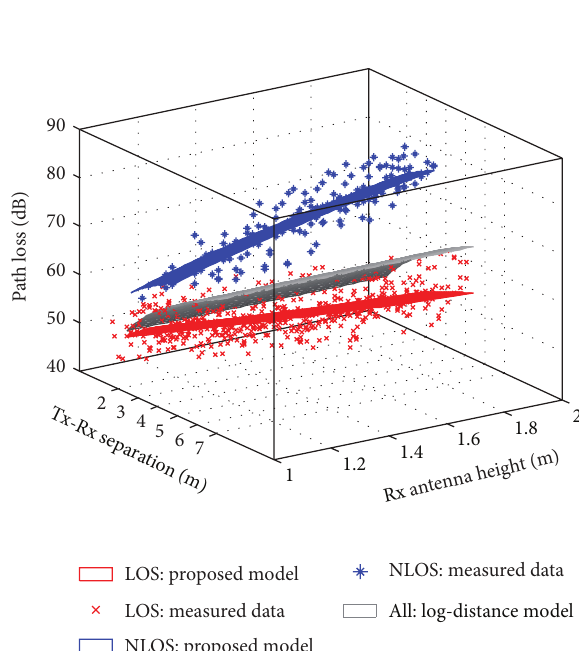
Figure 6: Scatter plots of measured data and corresponding fit surfaces of the proposed model and the log-distance